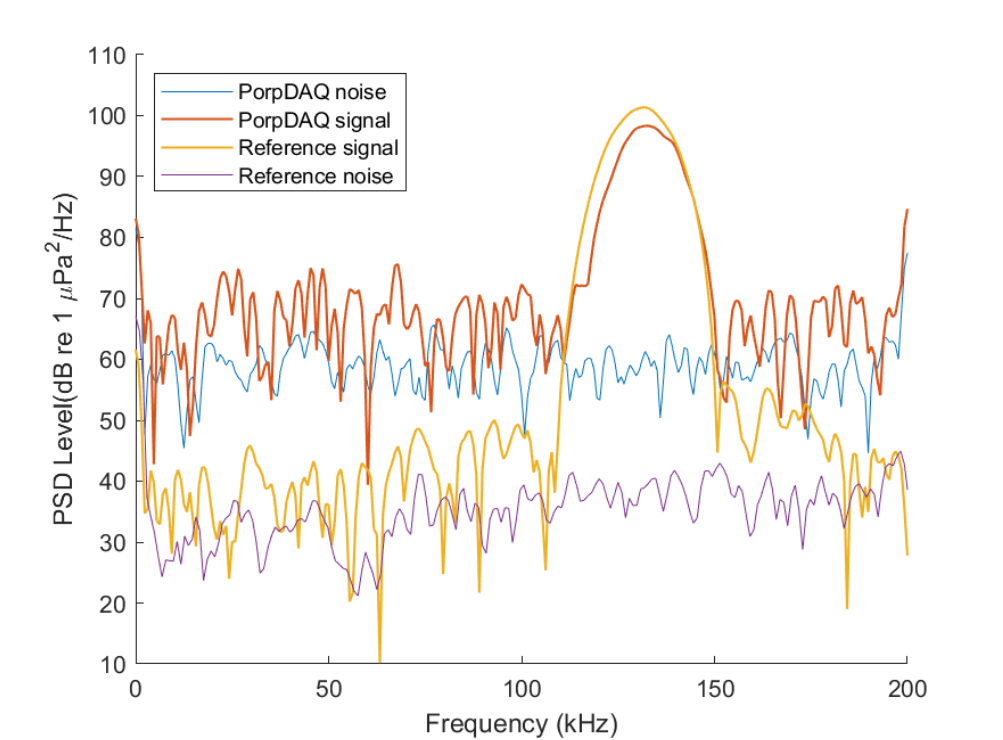
Figure 10. Power spectral density of the recorded background noise from the PorpDAQ (blue line) and the background noise from the reference system (purple line). The power spectral density of a click captured by both systems are also shown.